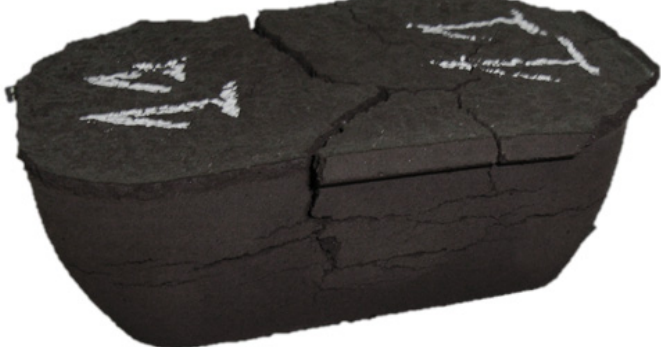
Figure 1. Sample showing cracks (5% Portland cement).